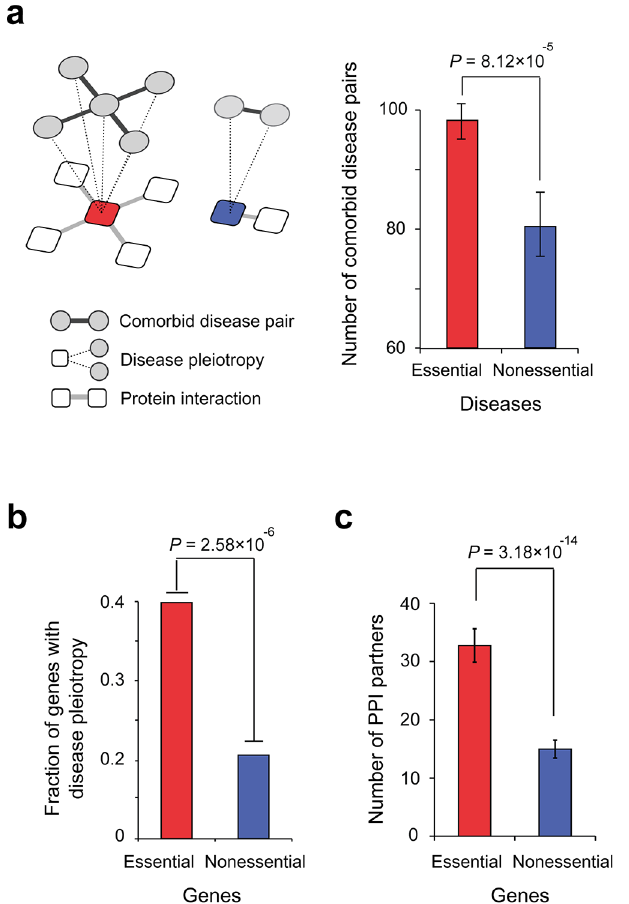
Fig 4. The comorbidity and pleiotropy of essential and nonessential gene-enriched diseases. (a) The comorbid disease pairs of essential and nonessential gene-enriched diseases. (b) The fraction of pleiotropic diseases connected by essential and nonessential genes. (c) The number of PPI partners of essential and nonessential disease genes.